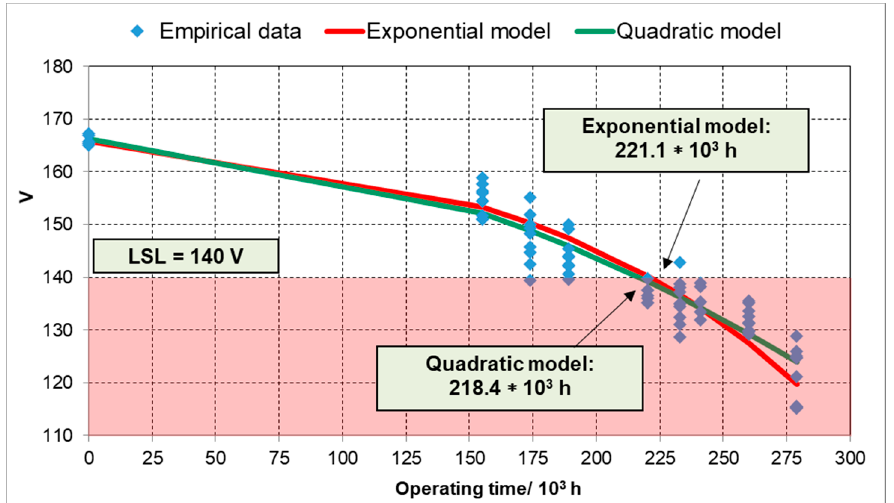
Figure 5. The course of the Vickers hardness change depending on the operating time for the elbow bend made of FS group steel at the longitudinal location of the samples